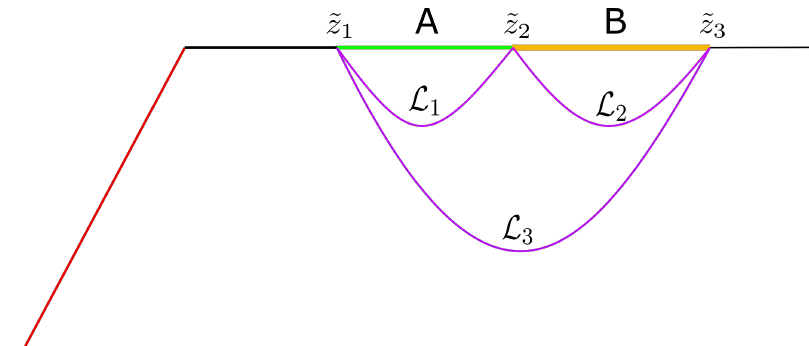
Figure 23. Geodesics contributing to the holographic entanglement negativity of adjacent intervals in